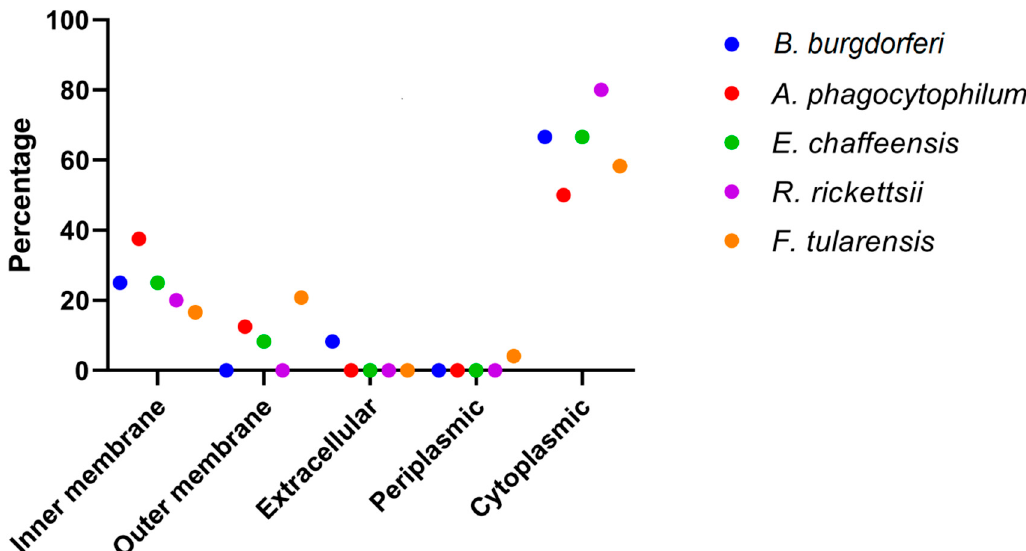
Figure2. Subcellularlocalizationoftargetproteinsshowingthemajorityarecytoplasmic. Borreliaburgdorferi Figure 2. Subcellular localization of target proteins showing the majority are cytoplasmic. Borrelia ( B. burgdorferi ), Anplasma phagocytophilum ( A. phagocytophilum ), Ehrlichia chaffeensis ( E. chaffeensis ), Rickettsia rickettsii ( R. rickettsii ), Francisella tularensis ( F. tularensis burgdorferi (B. burgdorferi), Anplasma phagocytophilum (A. phagocytophilum), Ehrlichia chaffeensis (E. chaffeensis), Rickettsia rickettsii (R. rickettsii), Francisella tularensis (F. tularensis).